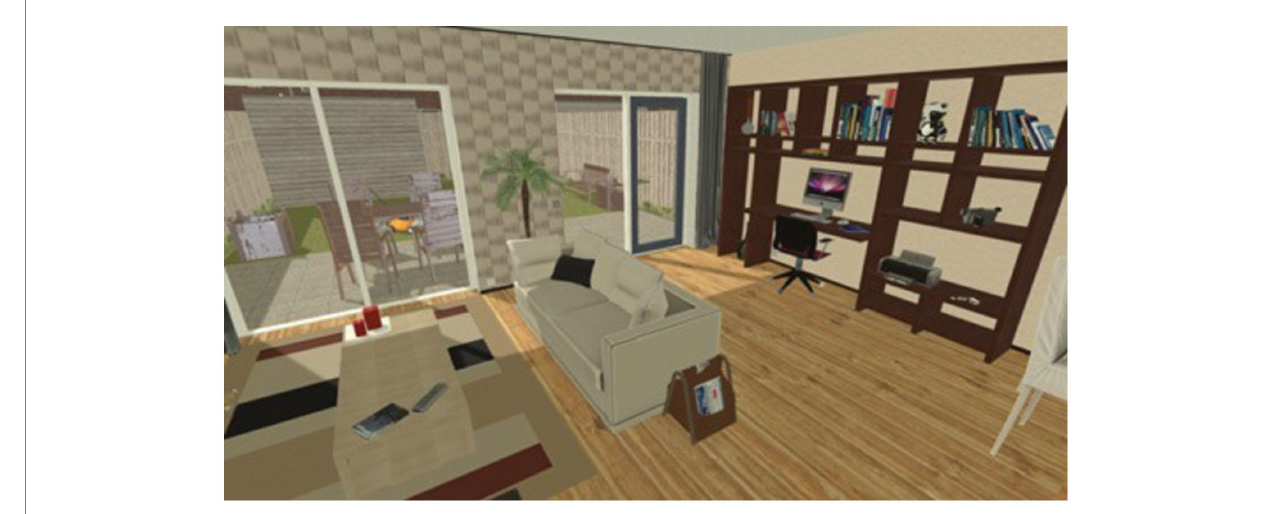
FIGURE 1 Image from within the virtual